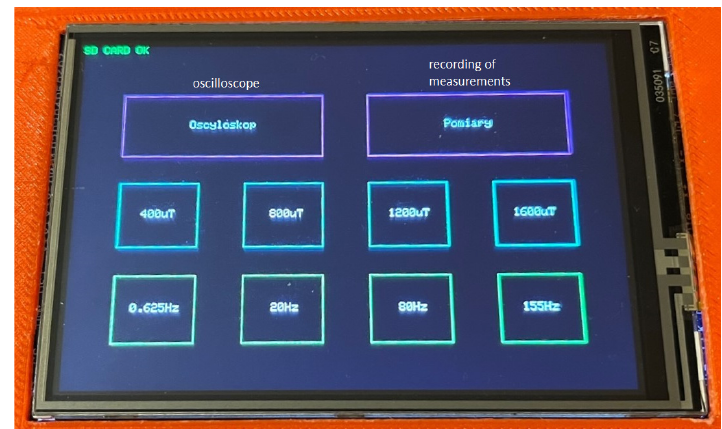
Figure 3. Screenshot with the option selection menu.